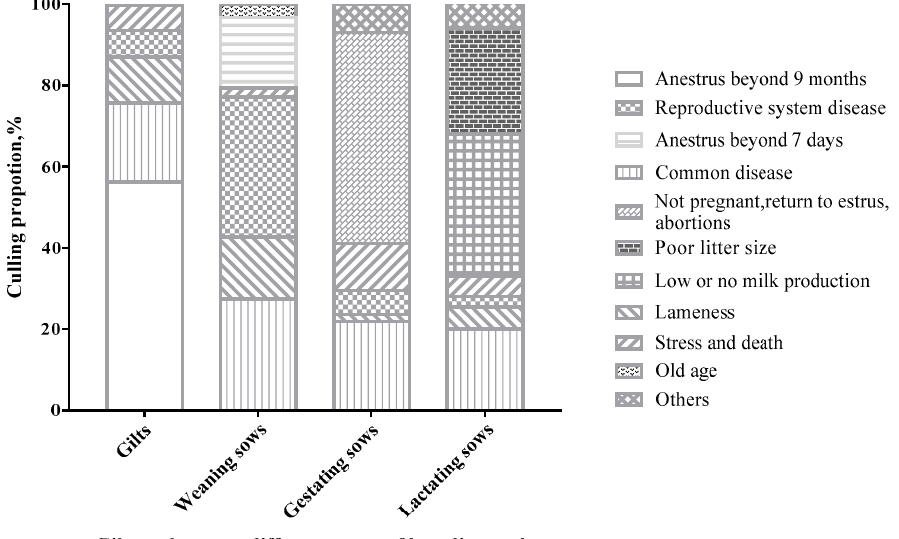
Figure 1. Culling reasons distribution in gilts and sows at di ff erent stages of the breeding cycle (gilts = 3685; weaned sows = 9079; gestating sows = 2967; lactating sows = 3740). The di ff erence between the proportion of reproductive system disease and stress and death for gilts, others, and reproductive system disease for gestating sows was not significant ( p > 0.05). In addition, the di ff erence between the proportion of others and lameness, others and stress and death, lameness and stress and death for lactating sows was also not significant ( p > 0.05). In addition to the above, the di ff erence between any two culling reasons for gilts, gestating sows ( p < 0.0033), weaned sows, and lactating sows ( p < 0.0024) was